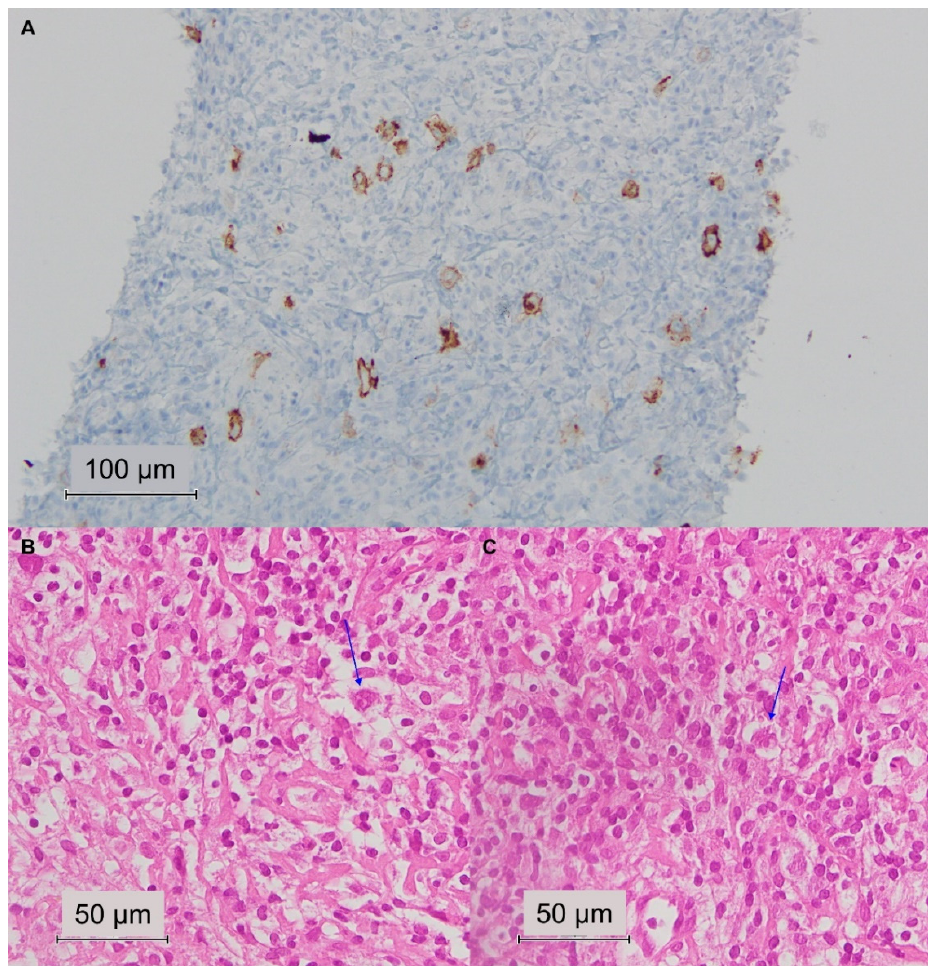
Figure 1. Hodgkin lymphoma arising from chronic lymphocytic leukemia. ( A ) Immunohistochemistry shows CD30 + neoplastic cells within the lateral cervical lymph node. ( B ) Hematoxylin and eosin staining displays an altered architecture characterized by an inflammatory infiltrate, and ( B , C ) rare large size mono-/bi-nucleated Hodgkin and Reed-Sternberg-like cells (highlighted with blue arrows).